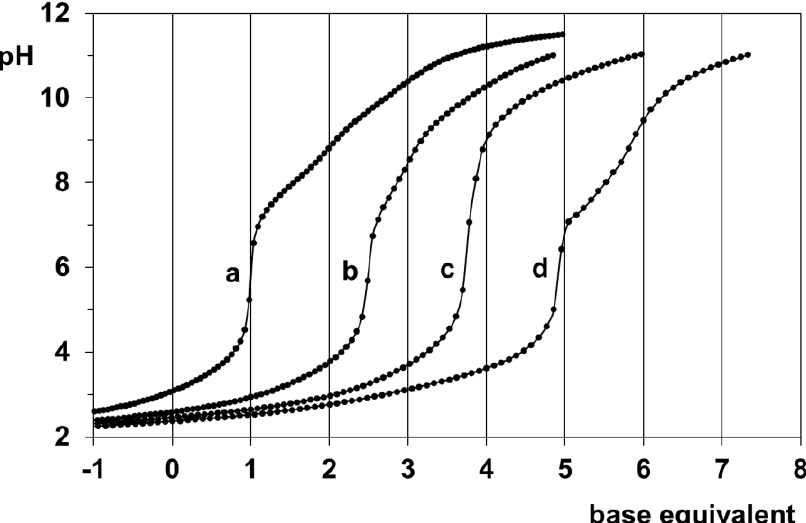
Figure 1. pH-potentiometric titration curves with H(L1) for the H + − ligand system ( a ), and the Pd(II)